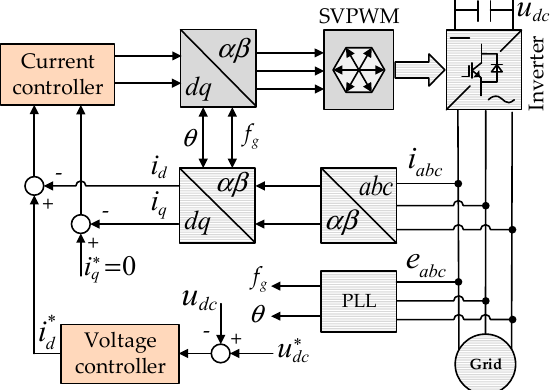
Figure 2. Schematic diagram of dual-loop control commonly used in grid-connected